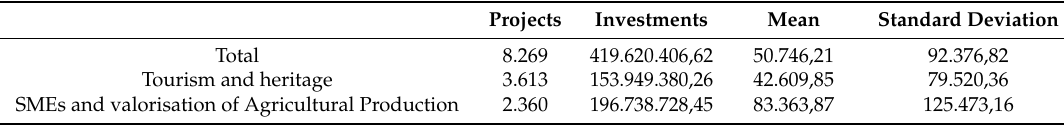
Table 1. Indicators of LEADER Approach